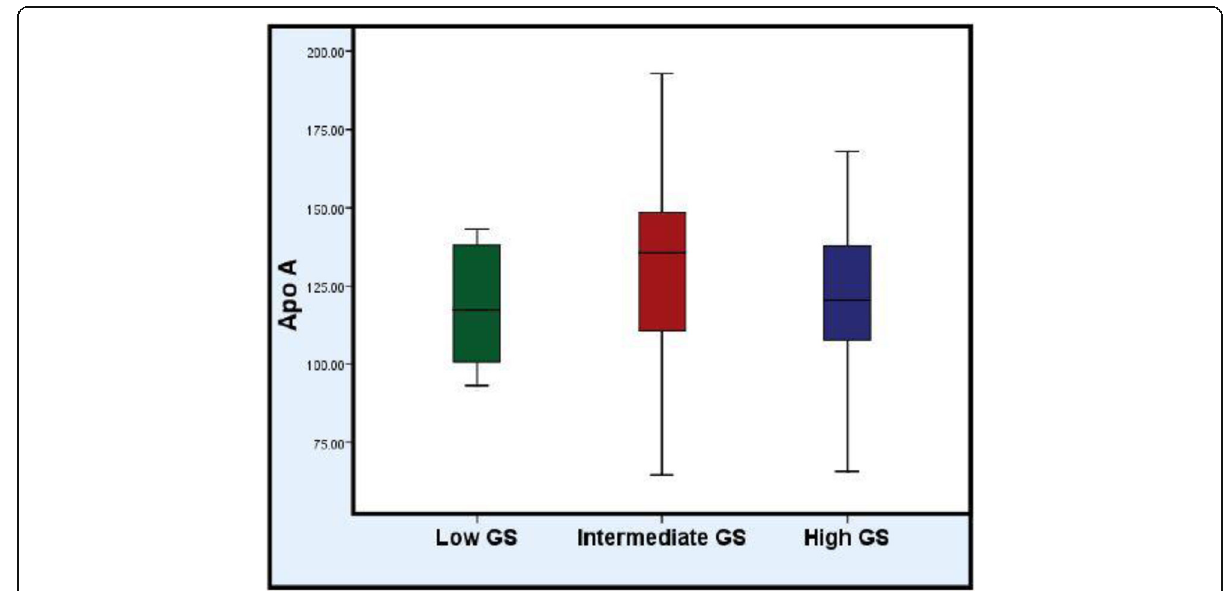
Fig. 2 Comparison between the studied patients as regard Apo A